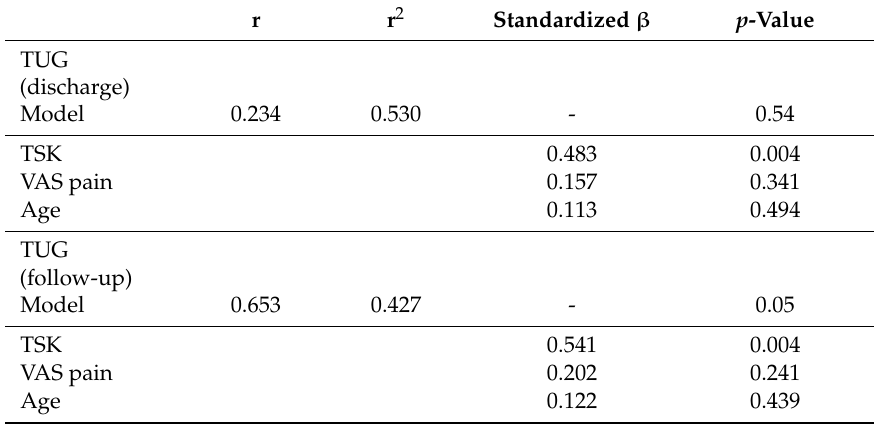
Table 3. Multiple linear regression